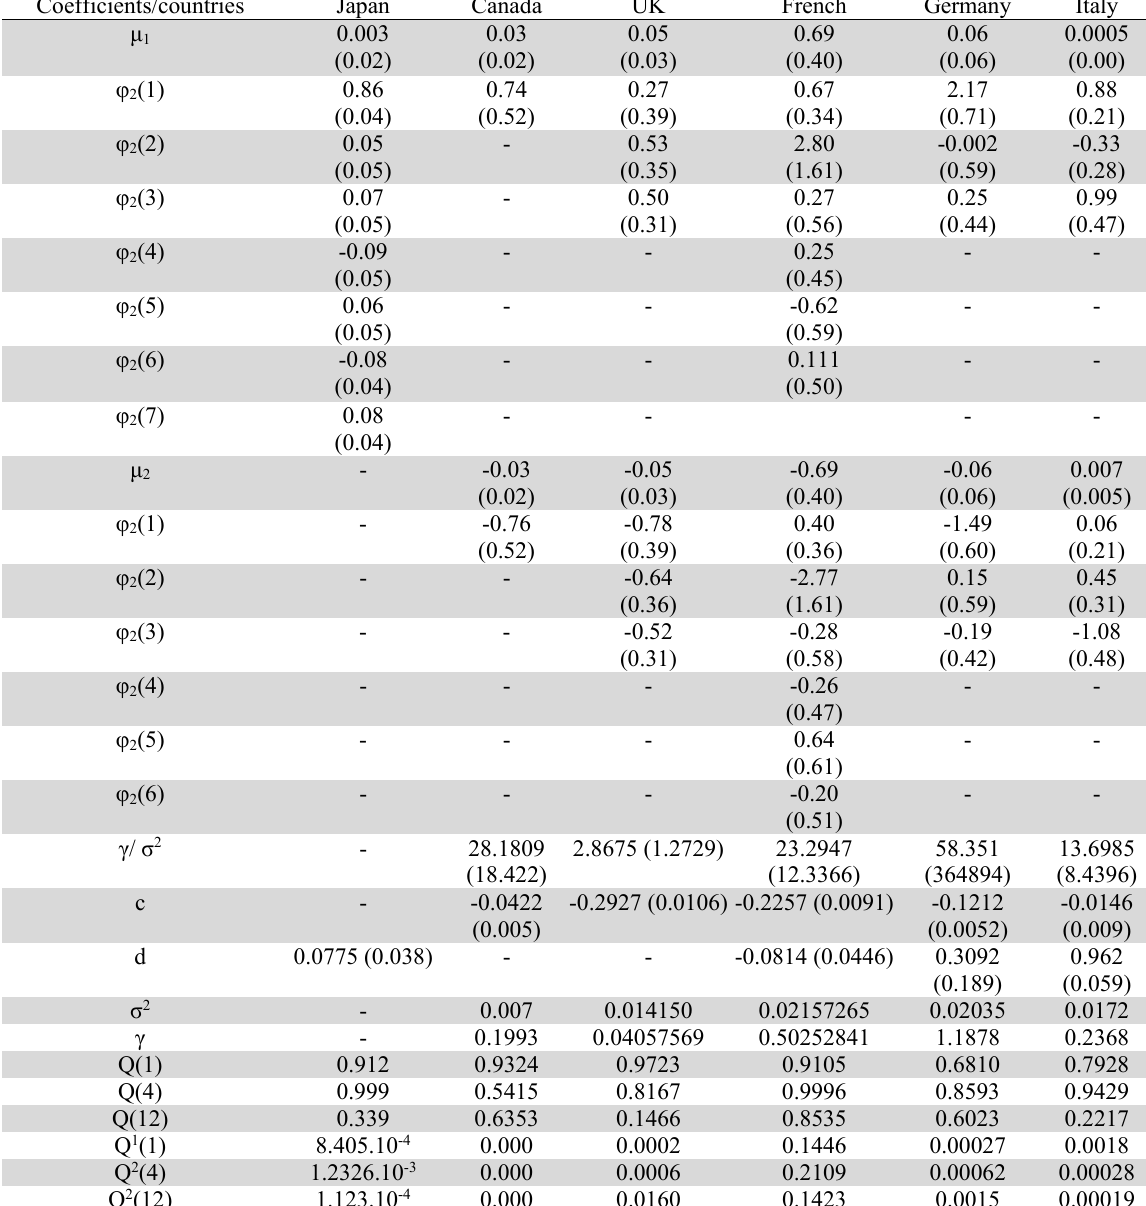
Estimation results based on the preferred model for the real exchange